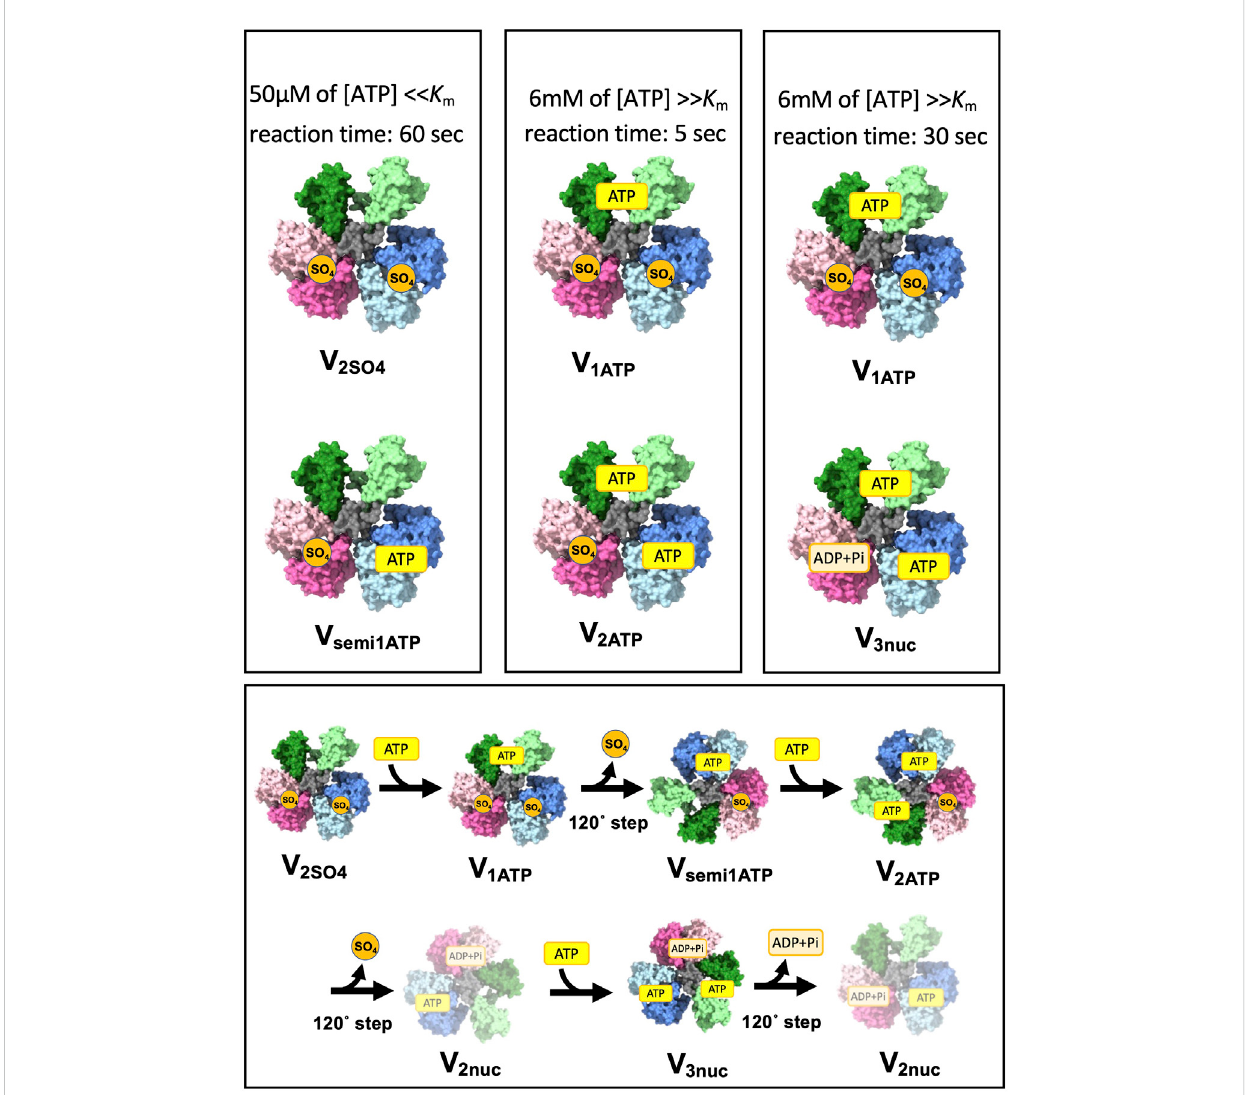
Short-lived initial intermediate V 1 structure captured by a time-resolved cryo snapshot analysis. This fi gure shows the results of cryo-electron microscopy (CryoEM) analysis of the structural changes in a nucleotide-depleted V/A-ATPase enzyme upon reaction with different ATP concentrations. The upper columns represent the initial intermediate structures captured at different time points after the reaction with either 50 µM or 6 mM ATP. The lower column shows the structural transition from the initial intermediate structures to the fi nal, steady-state structures (V 2nuc and V 3nuc